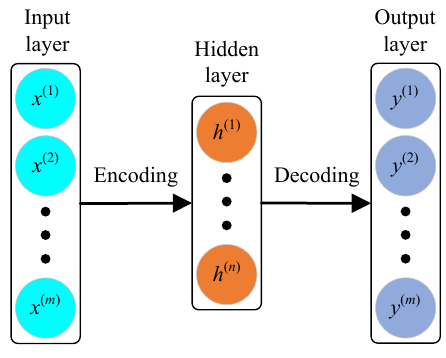
Figure 5. Basic structure of the auto